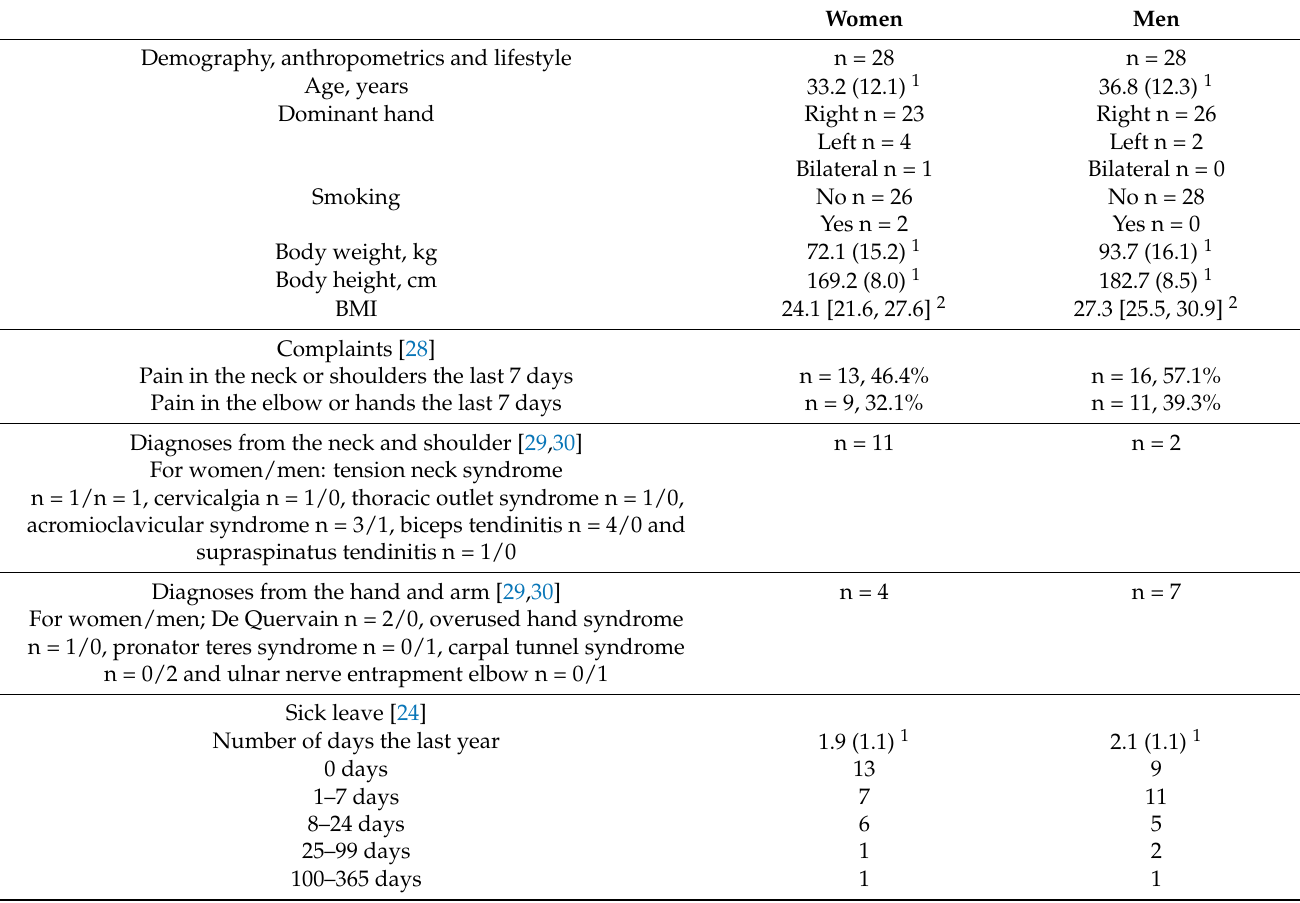
Table 2. Description of the